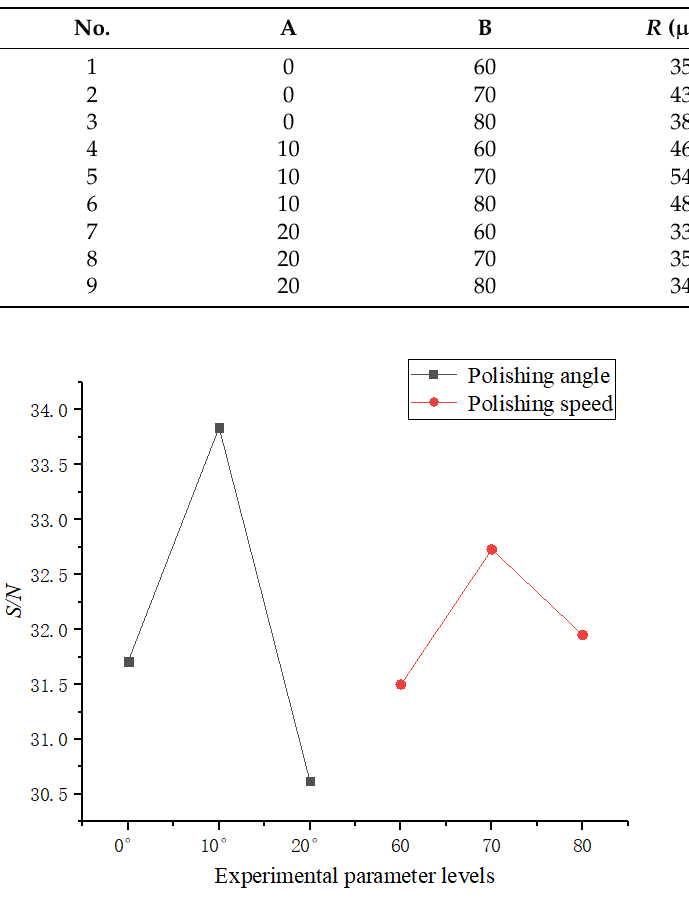
Figure 18. Plots of S/N ratio of each parameter level of R .